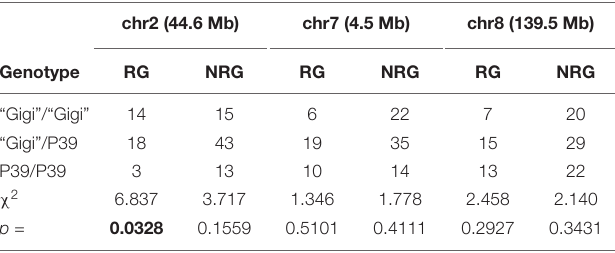
TABLE 4 | Genotype distribution of markers in field-grown P39/“Gigi” F 2 plants either showing regrowth (RG) or no regrowth (NRG). chr2 (44.6 Mb) chr7 (4.5